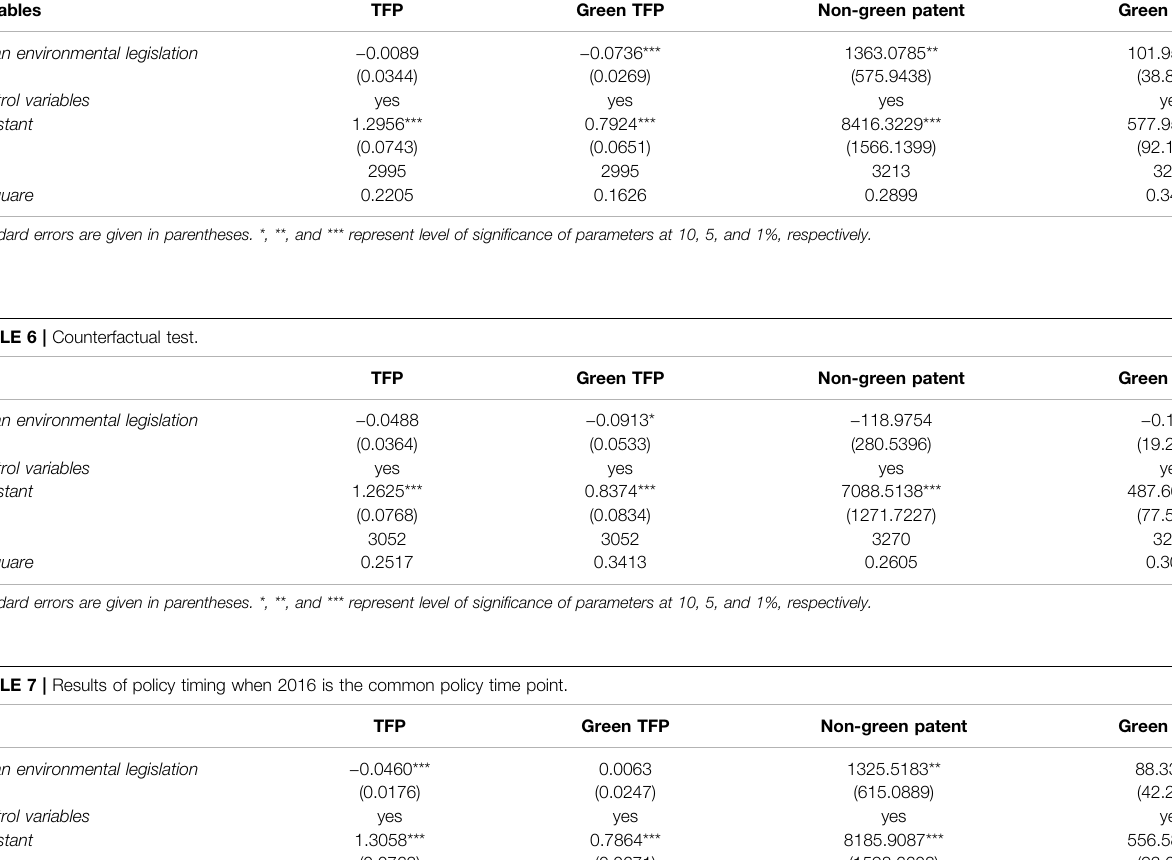
TABLE 5 | Estimated results based on the time of introduction. Variables